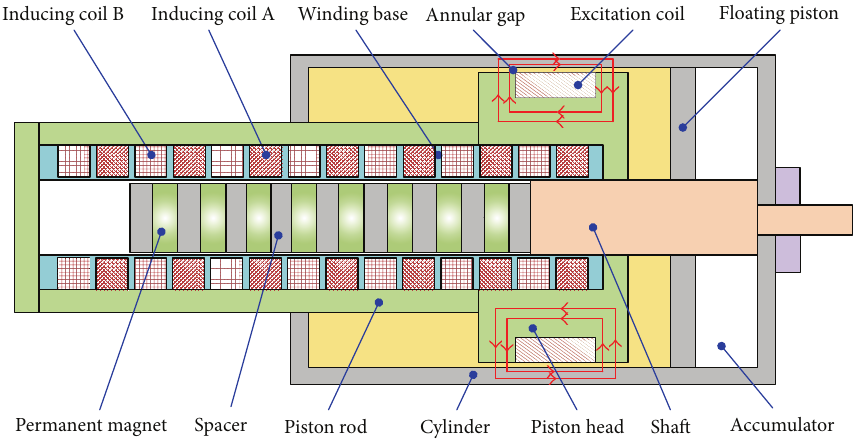
Figure 1: Schematic diagram of the proposed MR damper with energy harvesting